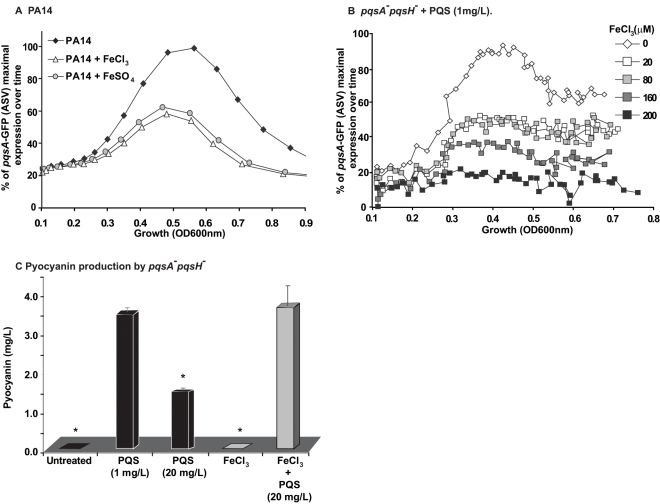
Homeostatic interplay between PQS and iron: Iron fine-tunes PQS activities.The effect of iron on MvfR induction was tested using the pqsA-GFP reporter in PA14 (A) and PA14 pqsA
−::pqsH cells treated with PQS (1 mg/L) (B). The effect of iron on pyocyanin production was tested when PQS was supplied at 1 mg/L or 20 mg/L (C). The cells were grown in low iron medium D-TSB or in media supplemented with iron (FeCl3 or FeSO4, 200 µM). Asterisks show samples that are statistically significant different (P value<0.05) from the PQS 1 mg/L treated sample.